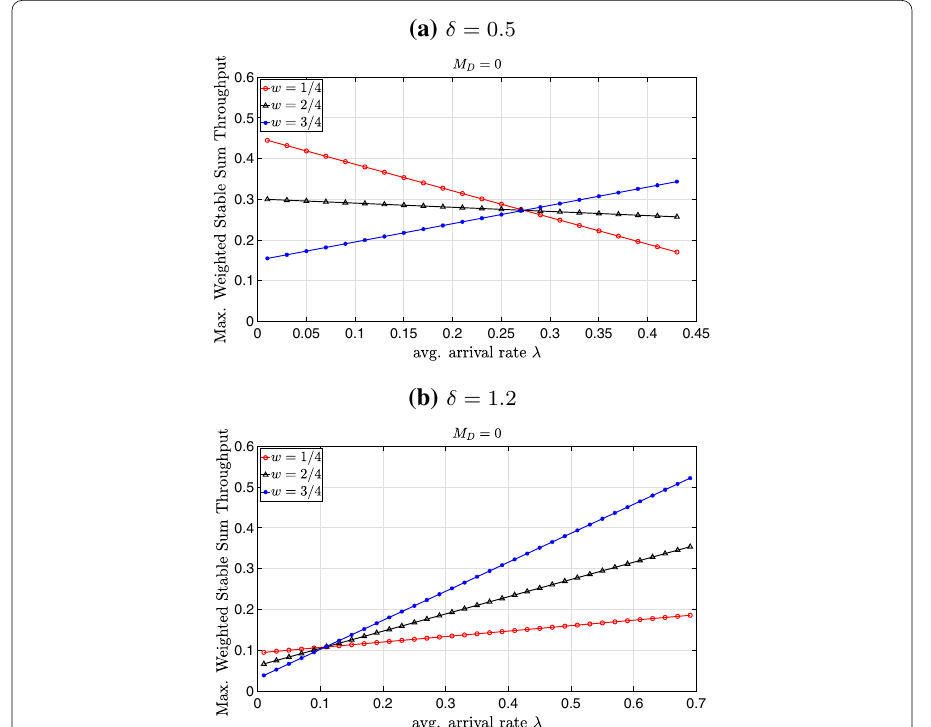
Fig. 8 The maximum weighted sum throughput vs the average arrival rate (cid:31) for which the queue at S is stable, M U = 200, M D = 0, M S = 2000, and α = 0.7 using different values of w for: ( a ) δ = 0.5 and ( b ) δ = 1.2